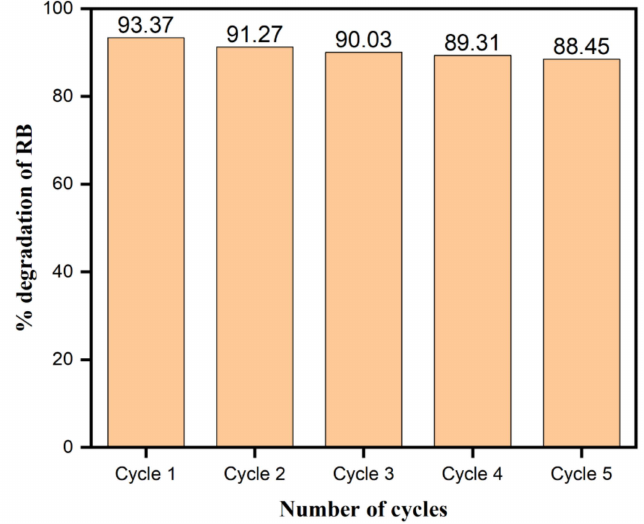
Figure 15. Recyclability study of AgNPs as a photocatalyst for the photodegradation of RB